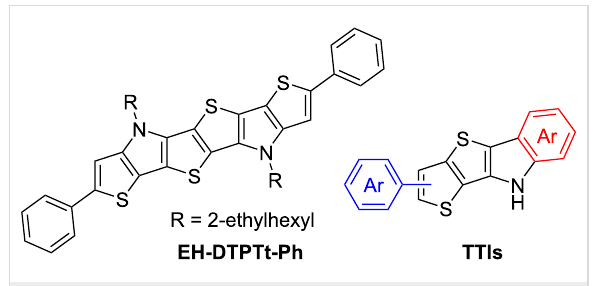
Figure 1: An example of an earlier developed S,N-heterohexacene [13] and general structure of compounds synthesized in this